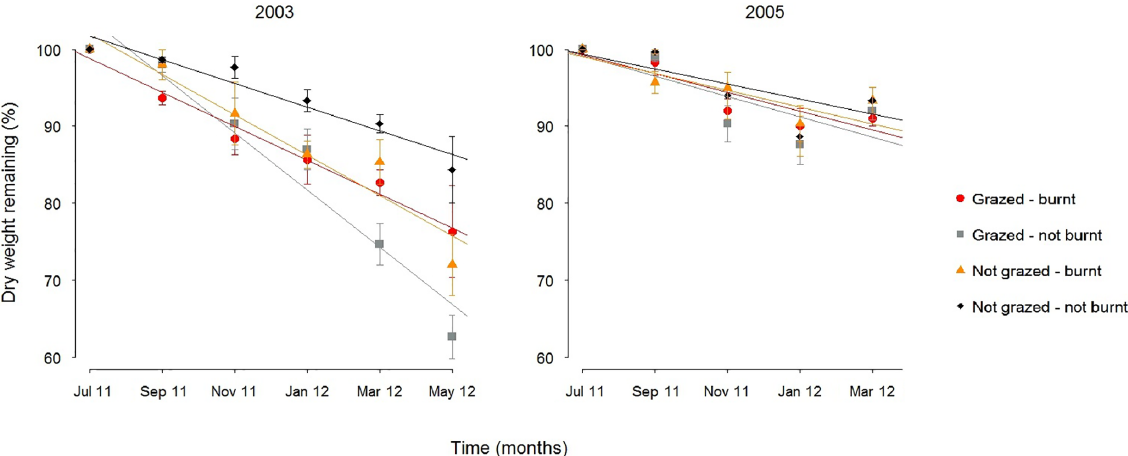
Figure 4. Mass losses (%) of sticks from the decomposition experiment ( n = 3) on two burnt sites (left, 2003 is Wayqecha; right, 2005 is Acjanaco) with grazed subplots and control plots.